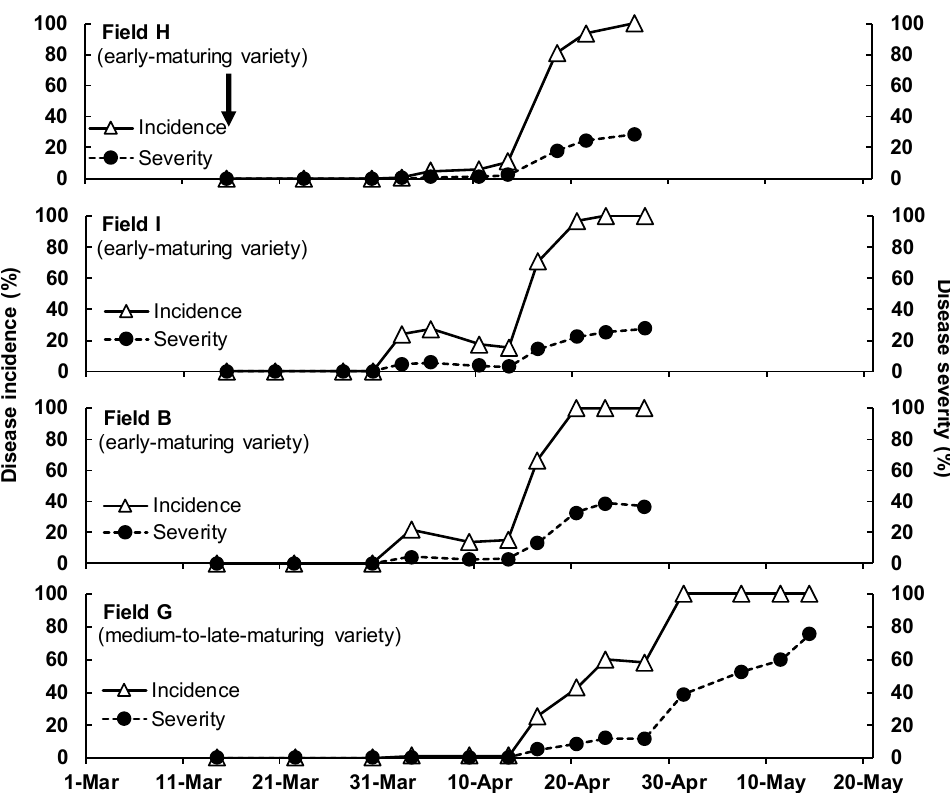
Figure 7. Development of onion downy mildew in unsprayed plots in 2018.